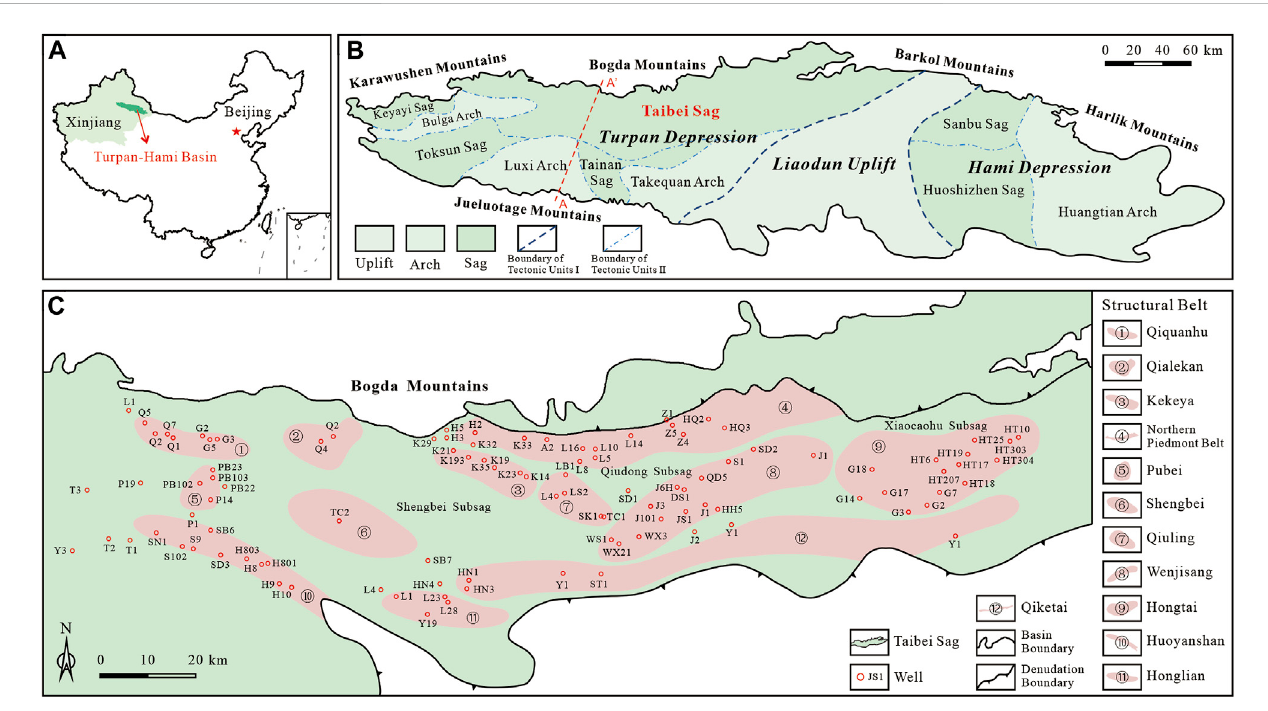
FIGURE 1 (A) Location of the Turpan-Hami Basin in China. (B) The tectonic unit divisions of the Turpan-Hami Basin. (C) The tectonic subunit divisions with the hydrocarbon-bearing structural belts and major wells in the Taibei Sag (modi fi ed from Hao et al.,